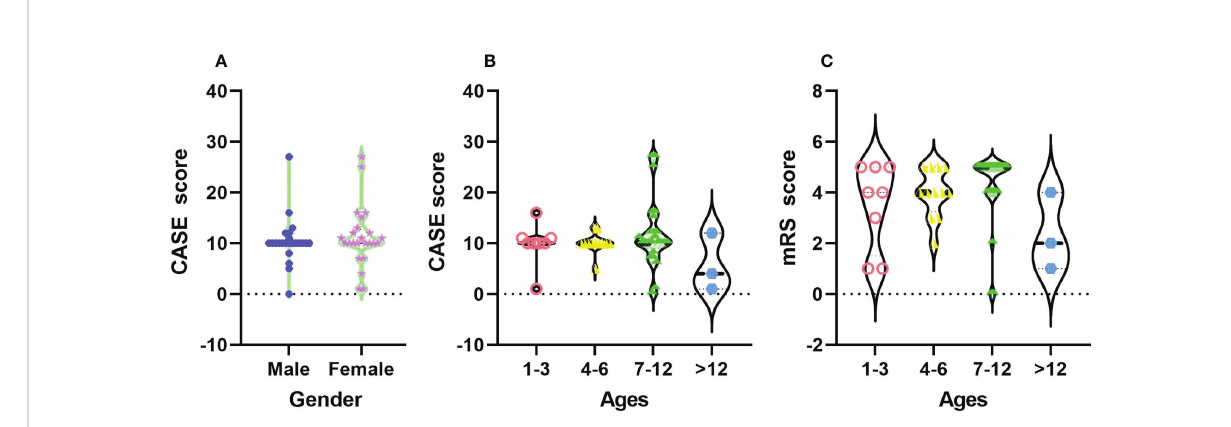
FIGURE 2 The distribution of CASE total scores among different sexes (A) and the total CASE (B) and mRS (C) scores by age at admission.